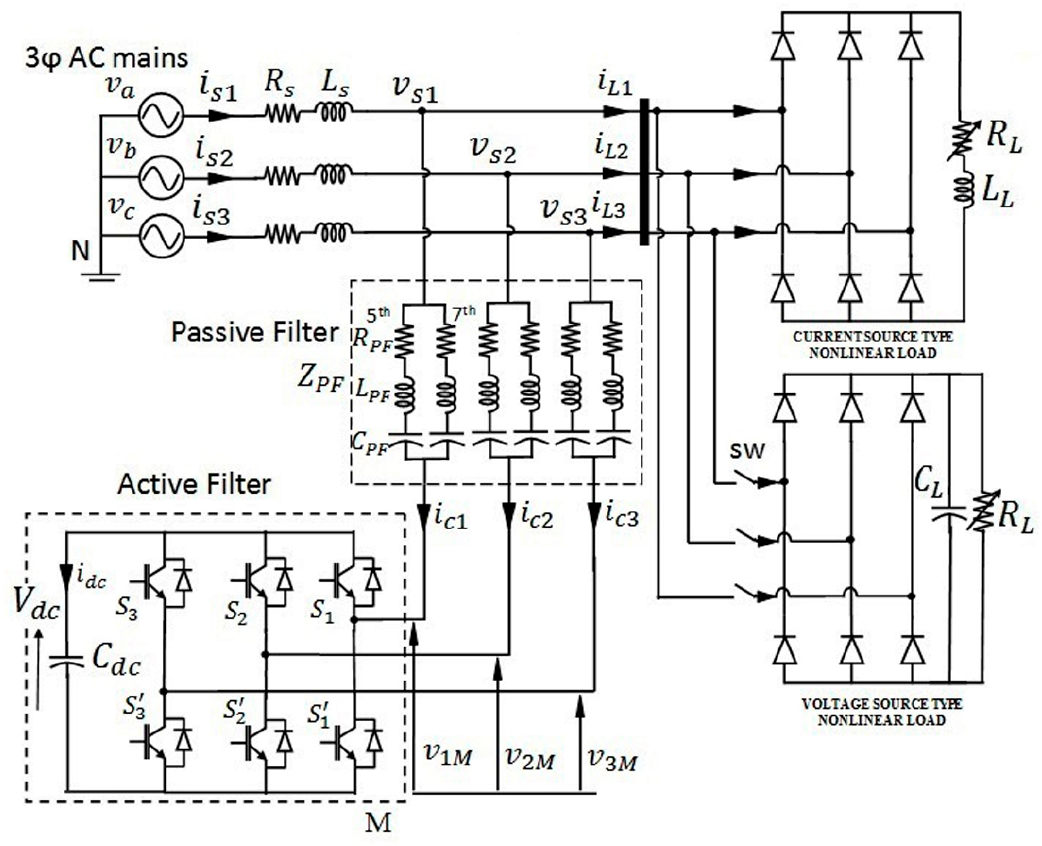
Figure 1. Configuration of the shunt hybrid compensator.